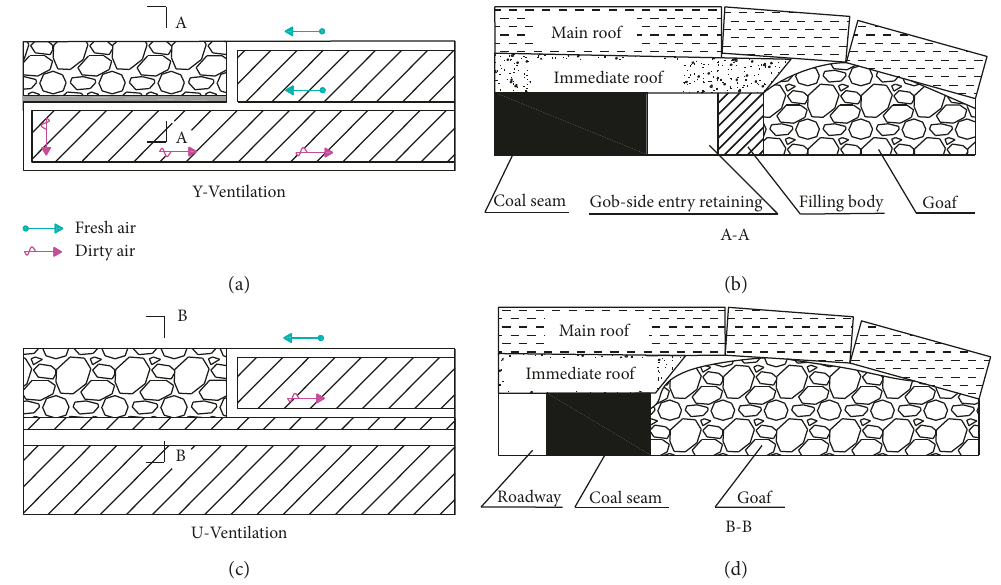
Figure 1: The traditional mining method and mining method of gob-side entry